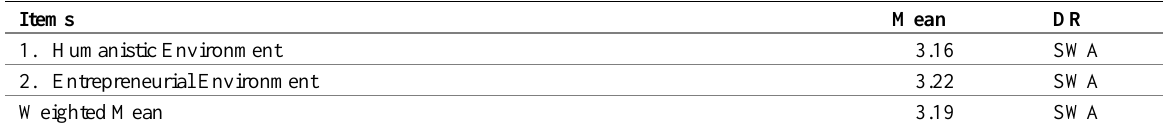
Table 6: Summary of Work Environment